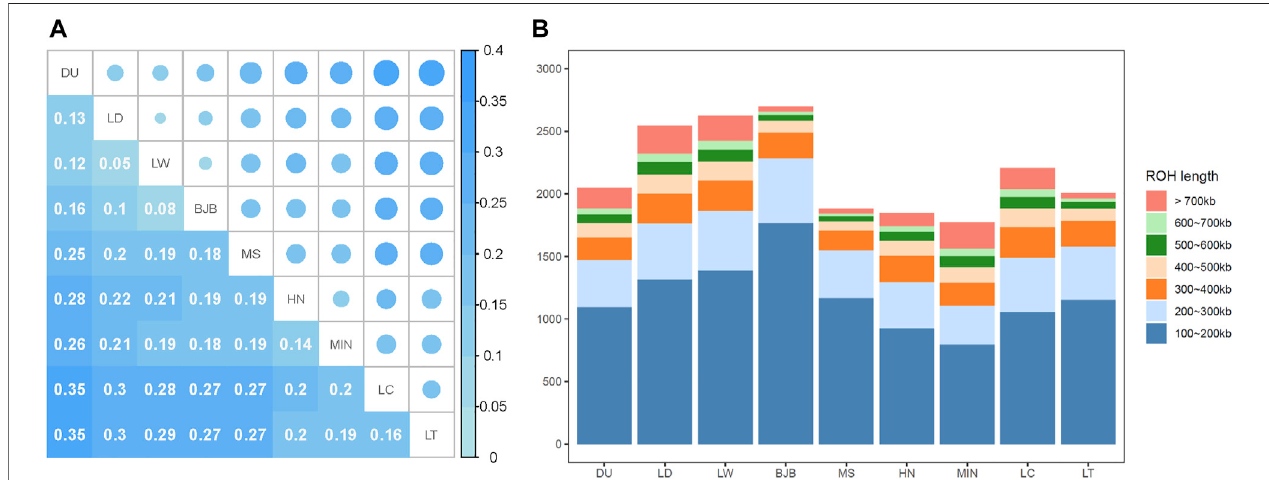
FIGURE 3 | Genetic diversity of Beijing Black pigs. (A) Heatmap of F ST distance between breeds. (B) The average number of ROH fragments of each breed. The number of ROH was classi fi ed into seven categories.